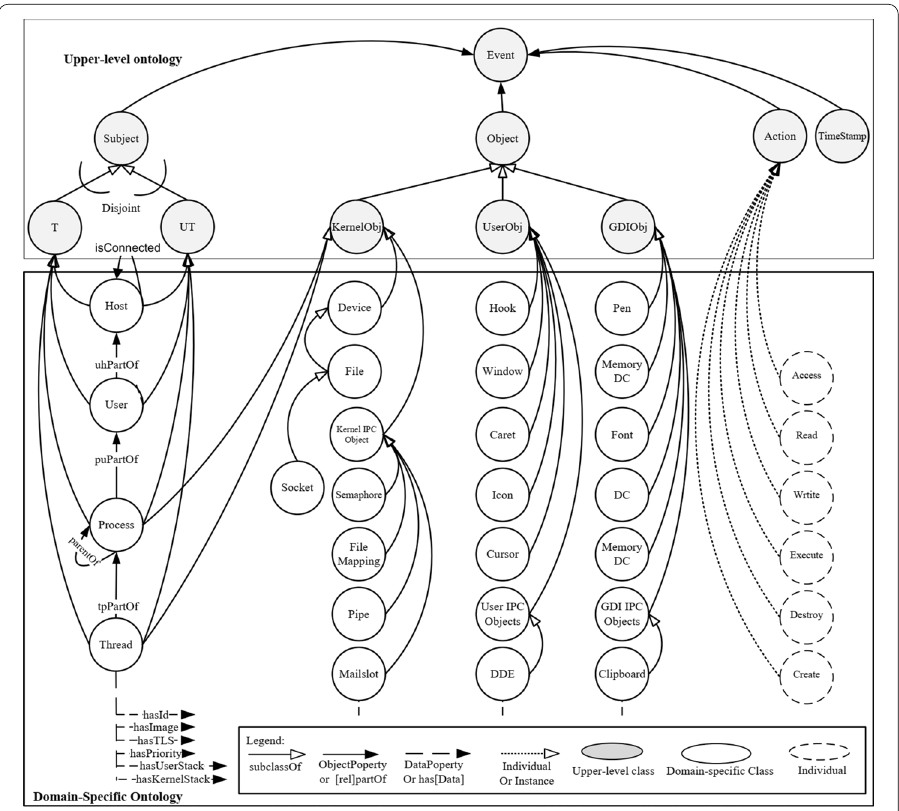
Fig. 5 Upper-level ontology of Windows operating system objects